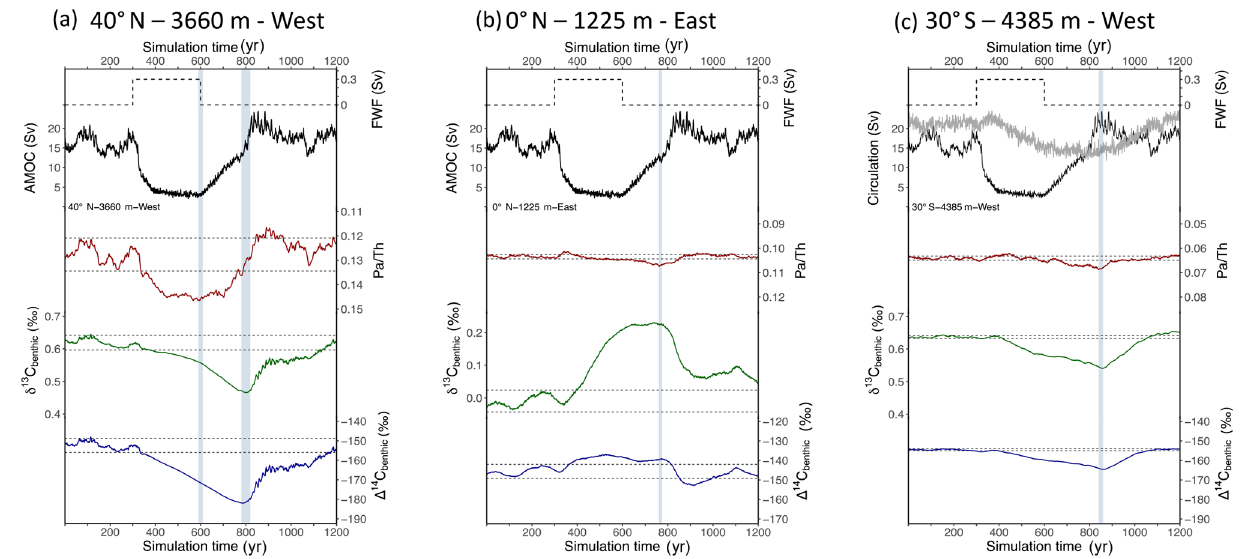
Figure 5. Selected multiproxy time series for the Nordic Seas hosing experiment representing the three main Atlantic water masses. (a) Zon- ally averaged on the western Atlantic basin time series at 40 ◦ N, 3660m. This time series is representative of the proxy behaviours in the NADW. (b) Zonally averaged on the eastern Atlantic basin time series at 0 ◦ N, 1225m. This time series is representative of the intermediate waters. (c) Zonally averaged on the western Atlantic basin time series at 30 ◦ S, 4385m. This time series is representative of the proxy re- sponse in the Antarctic Bottom Water (AABW). In the eastern basin, the δ 13 C generally displays two responses, first increasing (not shown) and then decreasing (as shown). In each subplot from top to bottom, the dashed black line represent the freshwater flux (FWF) applied in the Nordic Seas, the black line represents the North Atlantic maximum stream function (a–c) , the grey line represents the Southern Ocean maximum stream function (c) , the red line represents the particulate Pa / Th, the green line represents the δ 13 C and the blue line represents the (cid:49) 14 C. The thin dashed black lines represent the proxy variance (2 σ ) in the first 300 simulated years. The blue vertical bands indicate the timing of the proxy